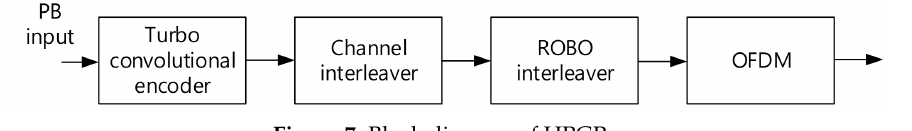
Figure 7. Block diagram of HPGP.